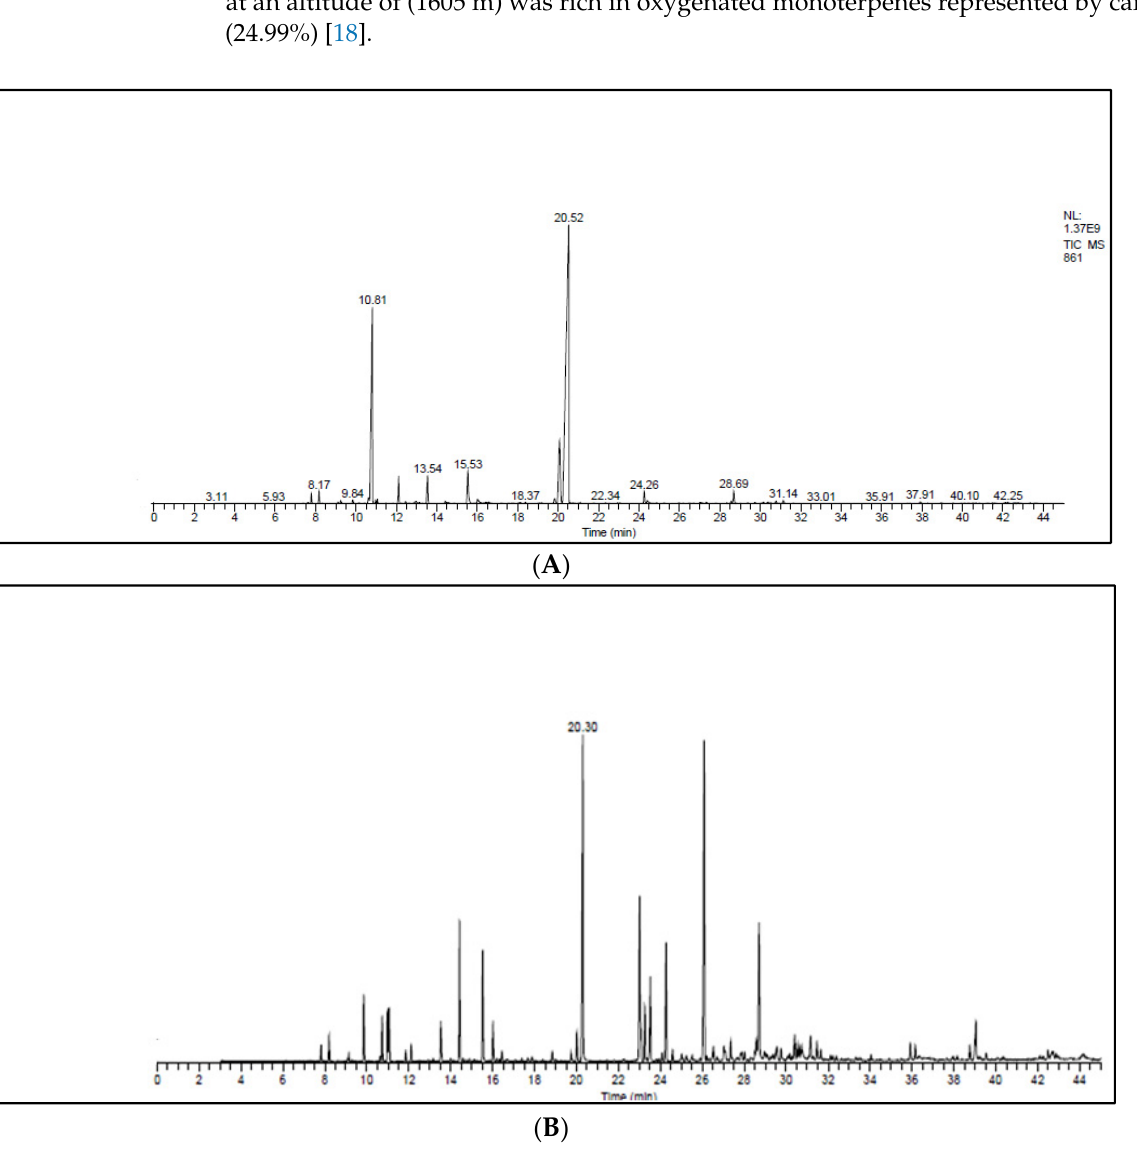
Figure 1. Chromatograms of the EOs. ( A ) T.zygis, ( B ) T.willdenowii. Table 3. Chemical composition of the thymes EOs.